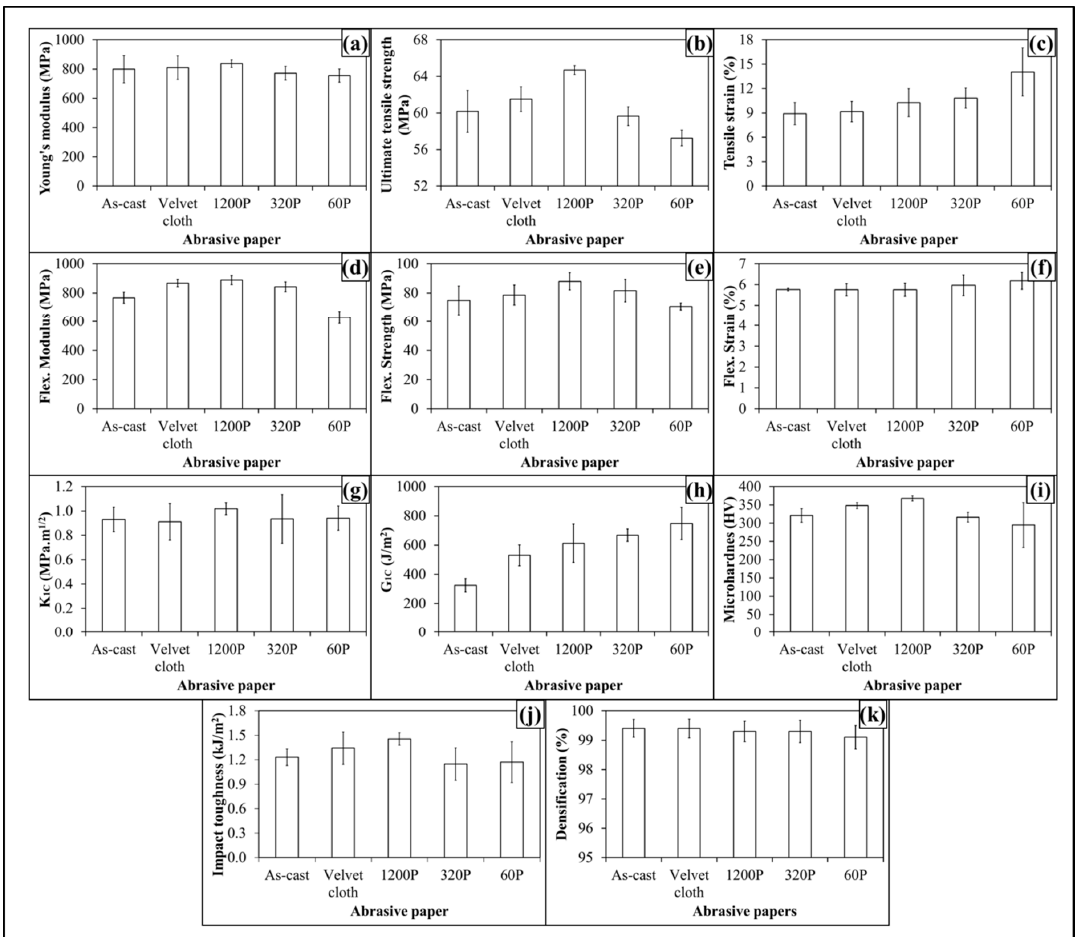
Figure 8. Mechanical properties of 0.1 wt % MLG-EP nanocomposites: ( a ) Young’s modulus (MPa); ( b ) UTS (MPa); ( c ) tensile strain (%); ( d ) flexural modulus (MPa); ( e ) flexural strength (MPa); ( f ) flexural strain (%); ( g ) K 1C (MPa.m 1/2 ); ( h ) G 1C (J/m 2 ); ( i ) microhardness (HV); ( j ) Charpy impact toughness (kJ/m 2 ); ( k ) densification (%).